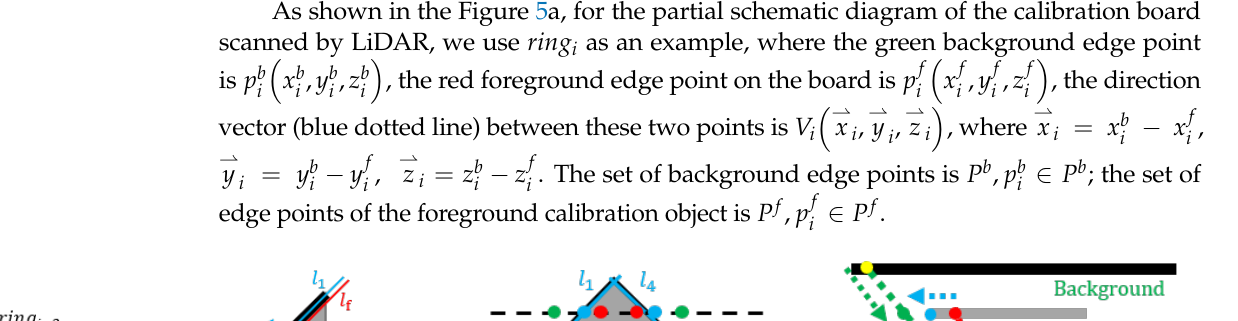
Figure 4. Point clouds distribution map with different 𝜃s , ( a ) is the top view of LiDAR, ( b ) is point clouds of three different 𝜃s and ( c ) is a partial diagram (black rectangle) of ( b ). Red point in ( d ) is 𝜃 = 0.1°, green point in ( e ) is 𝜃 = 0.2°, and blue point in ( f ) is 𝜃 = 0.4°.